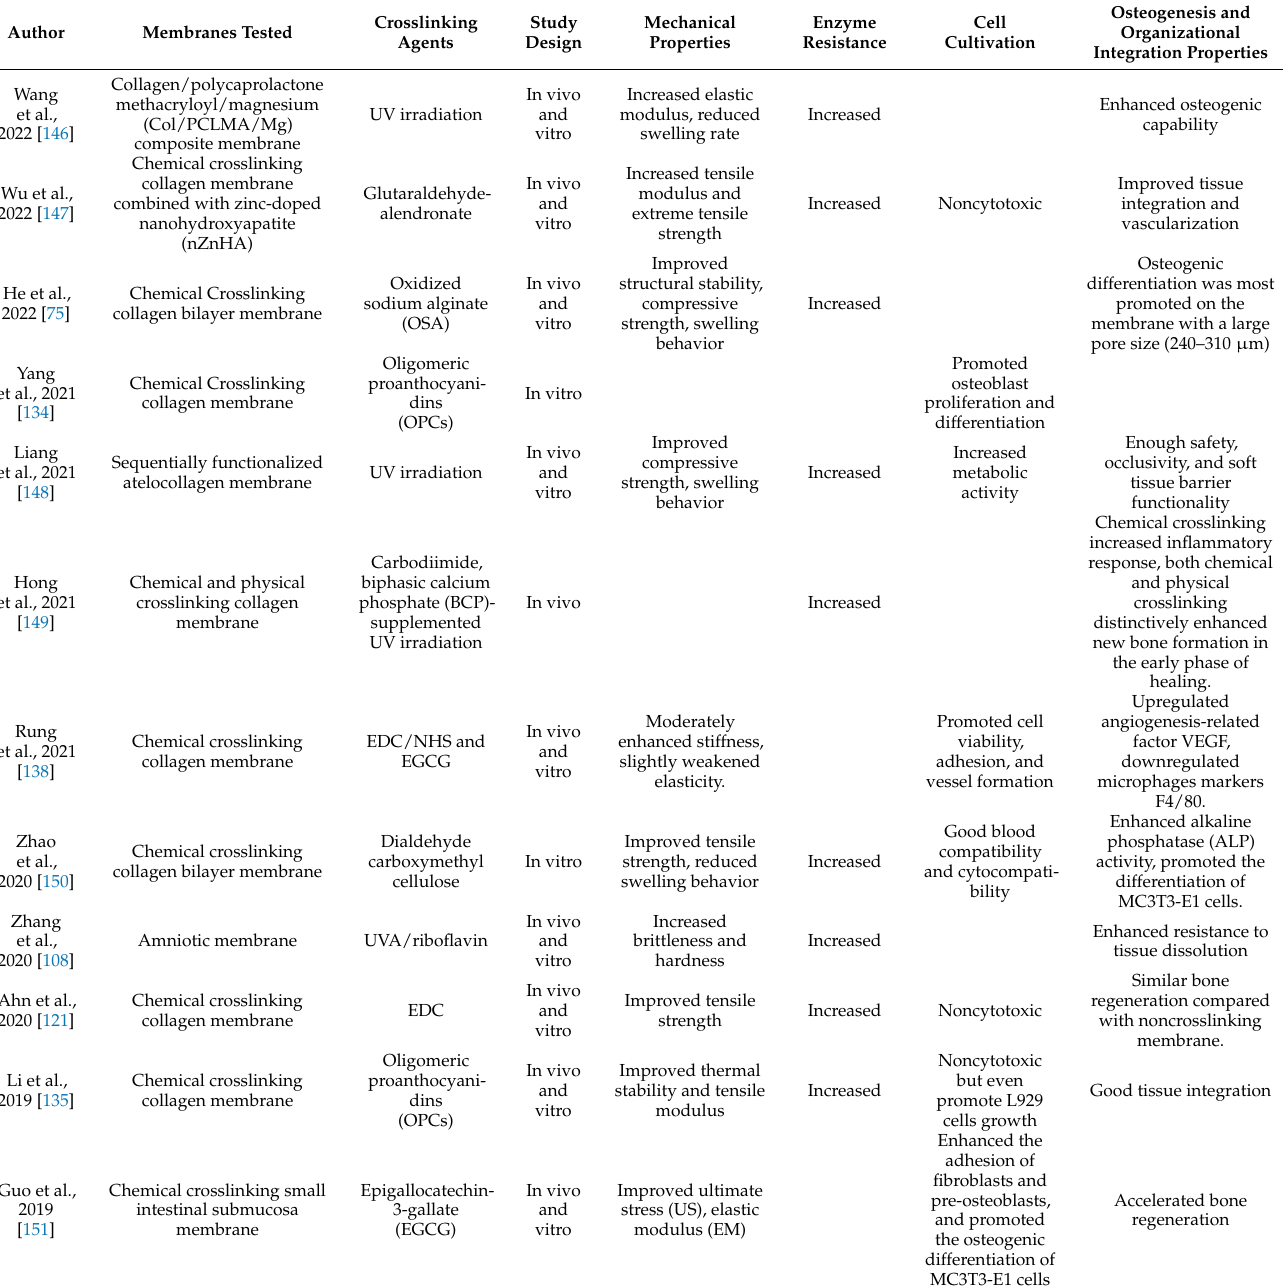
Table 1. Recent developments of crosslinked collagen membranes for guide bone regeneration